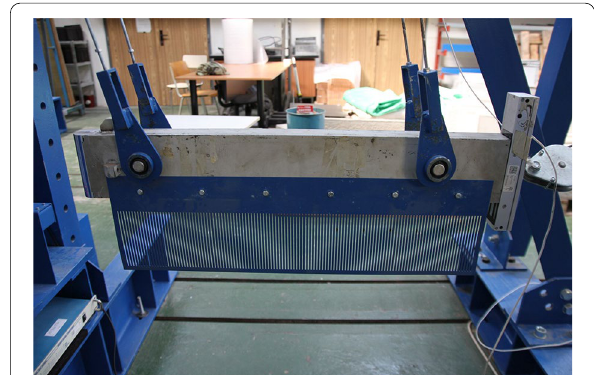
Fig. 3 The measuring attachment of the impactor.